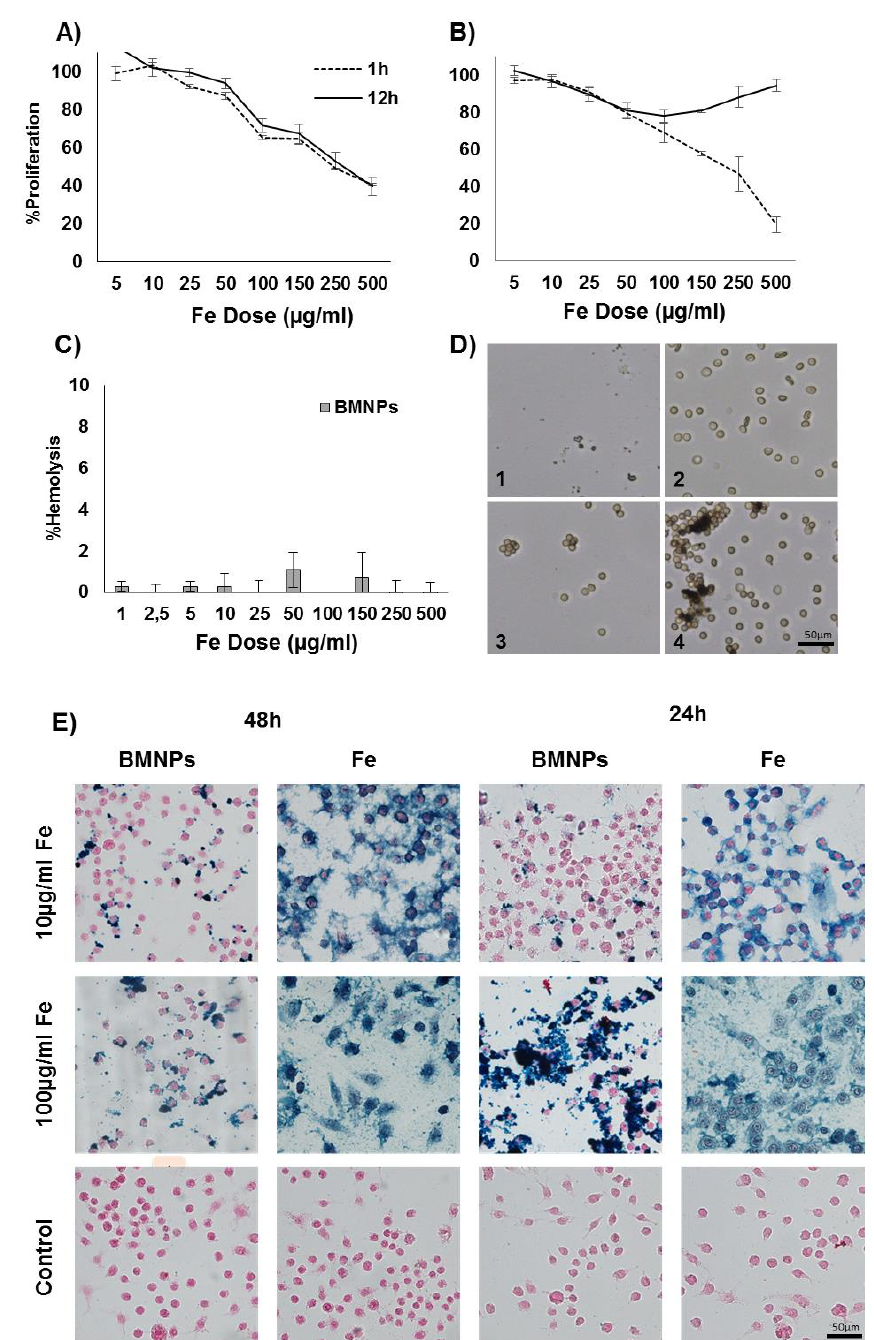
Figure 8. BMNP biocompatibility with blood cells. ( A ) Toxicity test in the cell line of RAW 264.7 macrophages. ( B ) Toxicity test in white blood cells (WBCs). ( C ) Hemolysis test. Data represent the mean values ± SD of triplicate samples. ( D ) Images of optical microscopy of erythrocytes after treatment. 1. Positive control, 2. negative control, 3. 25 µ g / mL Fe, and 4. 150 µ g / mL Fe. ( E ) Prussian blue staining of RAW 264.7 cell line.